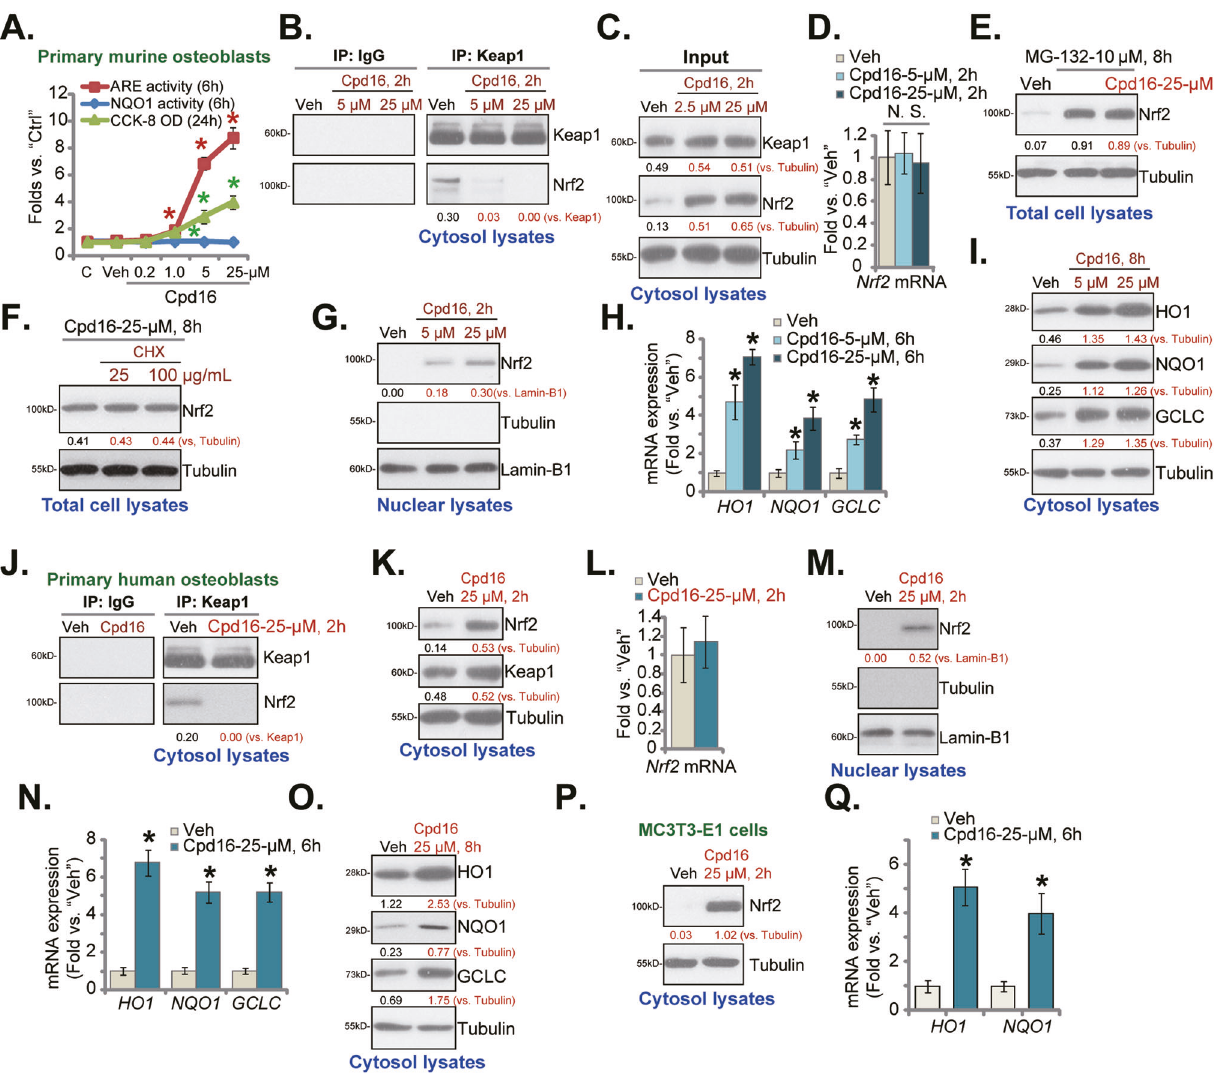
Fig. 1 Cpd16 activates Nrf2 signaling cascade in osteoblasts. Primary murine osteoblasts ( A – D , G – I ), human osteoblasts ( J – O ), or the MC3T3-E1 murine osteoblastic cells ( P , Q ) were stimulated with Cpd16, ARE activity and NQO1 activity as well as cell viability were measured ( A ); Keap1-Nrf2 association was measured through co-immunoprecipitation (Co-IP) ( B , J ); Proteins in cytosol/nuclear fraction lysates were examined ( C , G , I , K , M , O , P ), with mRNAs measured by qRT-PCR ( D , H , L , N , Q ). The primary murine osteoblasts were treated with